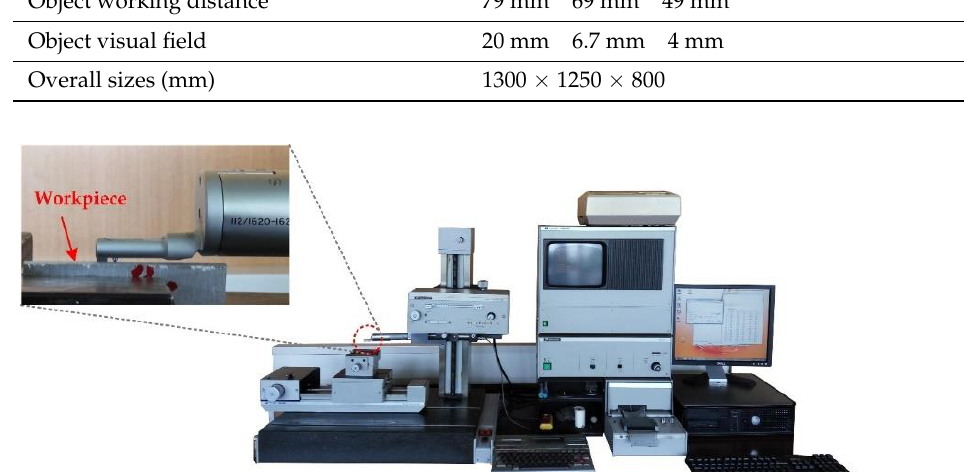
Figure 4. Taylor Hobson Talysurf 6 and example of surface roughness measurement. Table 4. Specifications of Universal Toolmaker’s Microscope . Figure 3. ( a ) Universal Toolmaker’s Microscope and ( b ) example of top and bottom kerf width.